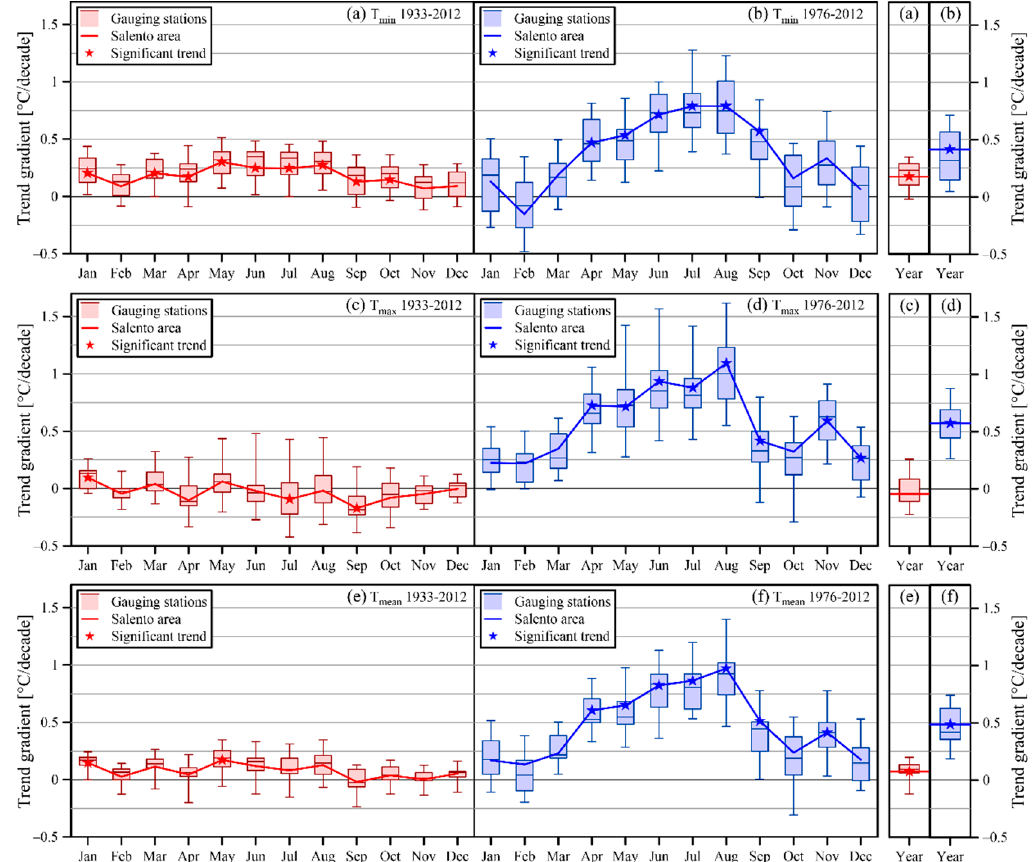
Figure 5. Monthly and annual temperature trend gradients as evaluated by the Theil-Sen estimator: minimum temperature (T min , ( a )), maximum temperature (T max , ( c )) and mean temperature (T mean , ( e )) for the whole period 1933–2012; T min ( b ), T max ( d ), T mean ( f ) for the shorter period 1976–2012. The box-whisker plots represent the variability between the 18 temperature gauges (the whiskers indicate the minimum and maximum values); the solid line depicts the trend gradient for the whole Salento area with an indication of its significance (95% confidence level).